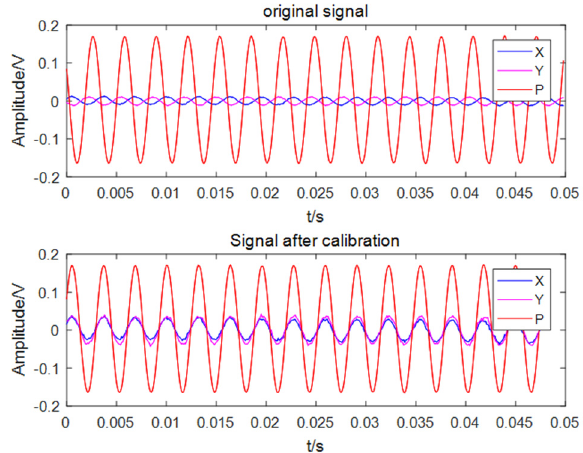
Figure 10. Phase-calibrated signal and original signal.